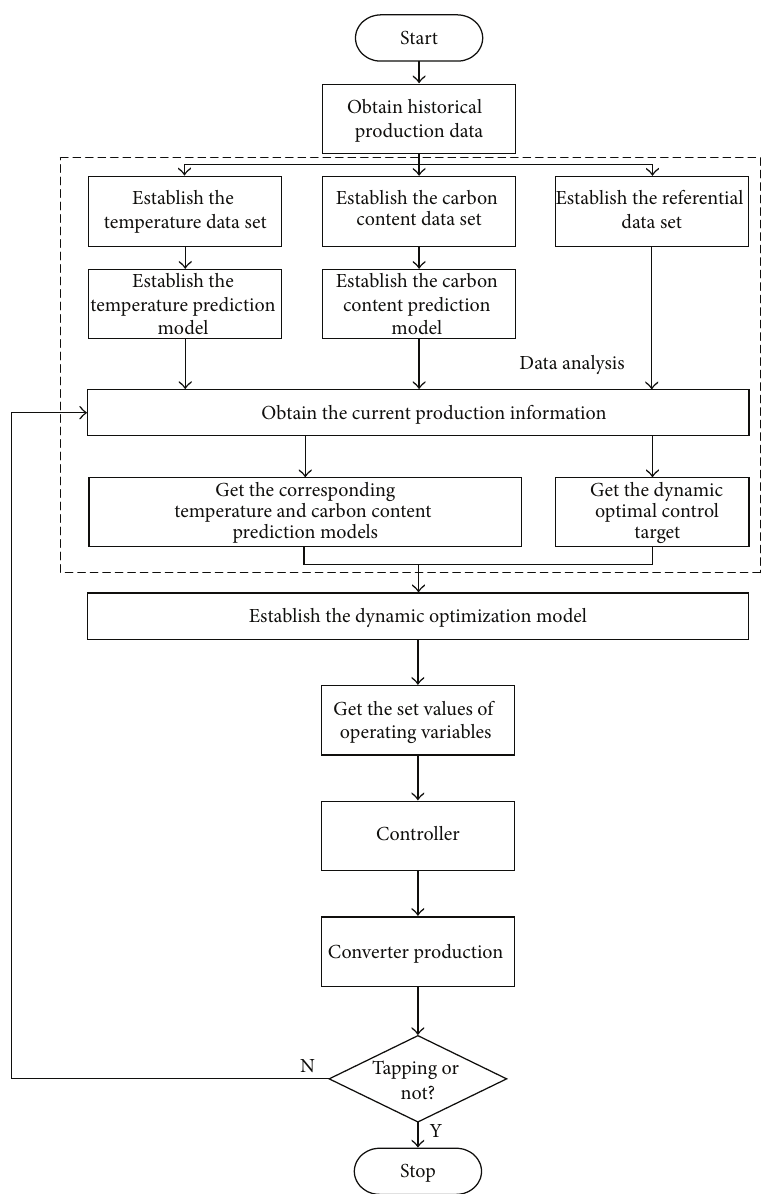
Figure 3: The operation optimization method in BOF steelmaking